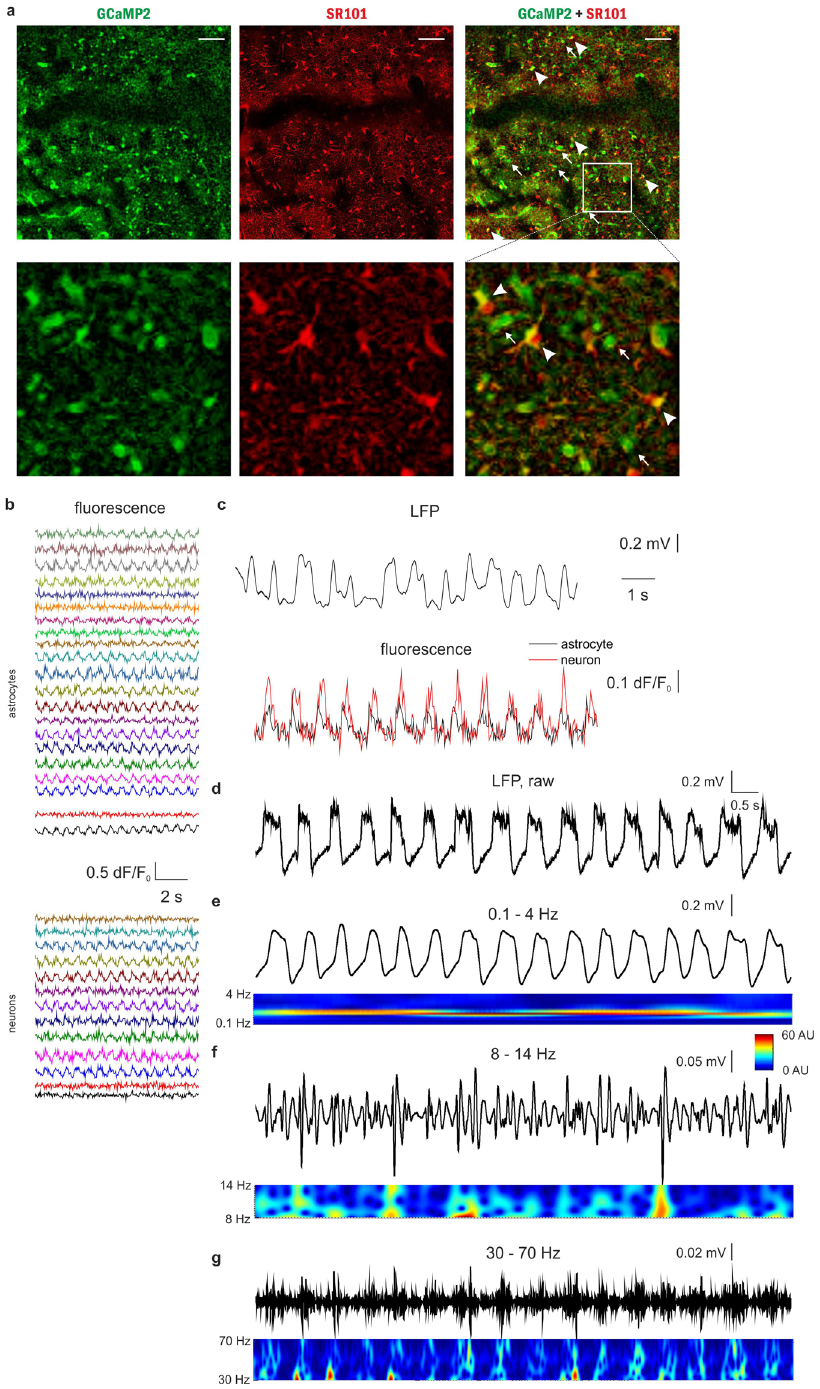
Figure 3. Both astrocytes and neurons are active during UP states in vivo in the rat primary visual cortex V1. ( A ) Top: Expression of GCaMP2 (green), labeling of astrocytes with SR101 (red). Both neurons (some marked by arrows) and astrocytes (some marked by arrowheads) express GCaMP2. Bottom: Zoomed-in image of the area marked by white rectangle at the top row. Scale bars: 100 µ m. ( B ) 10-sec segments of ∆ F/F 0 fluorescent intensity traces of all identified astrocytes (n = 21) and neurons (n = 13) in the imaged area. ( C ) Simultaneous recording of local field potential (LFP, filtered at 0.1–4 Hz) and corresponding Ca 2 + transients in a neuron (black) and an astrocyte (red) during SWA under ketamine - xylazine anesthesia. ( D–G ) Characteristic LFP activity in the slow wave (0.1–4 Hz), spindle (8–14 Hz) and gamma (30–70 Hz) frequency ranges as filtered LFP recordings (top) and their wavelet transformations (bottom). All data were recorded from the V1 area of a P76 rat (n = 15 imaging session, 60 s